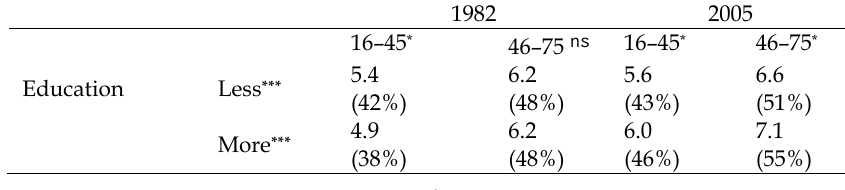
Table 4. Average number of correct responses in 1982 and 2005, control- ling for age and education. Percentage correct responses in